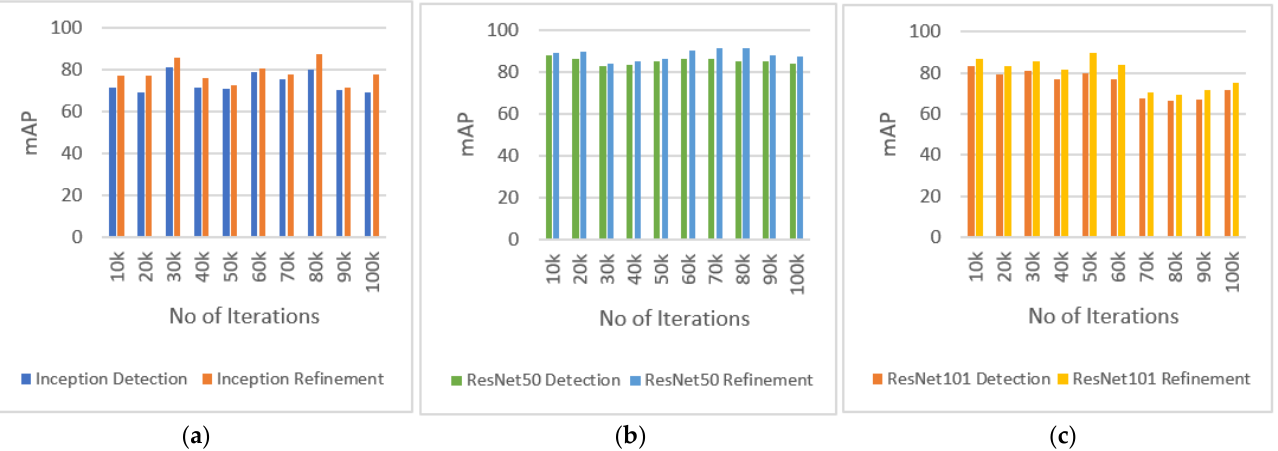
Figure 9. Experiment performed with image set 2 show mean average precision (mAP) of detection refinement with ( a ) detections with Inception model and refinements; ( b ) detections with ResNet50 model and refinements; ( c ) detections with ResNet101 model and refinements .